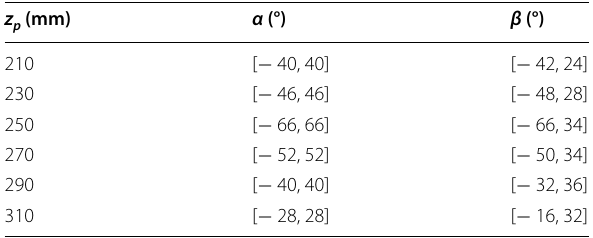
Table 1 Changes of kinematic parameters α and β of the moving